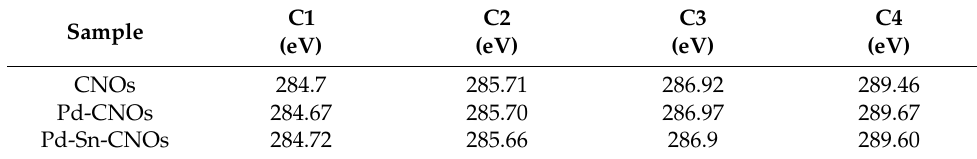
Table 3. Binding energies (in eV) of the four components of the C 1s core level for CNO samples.